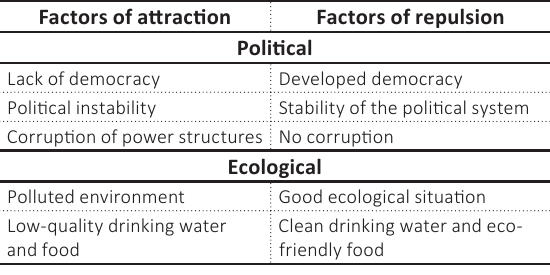
Source: Built by the authors based on Eurostat data